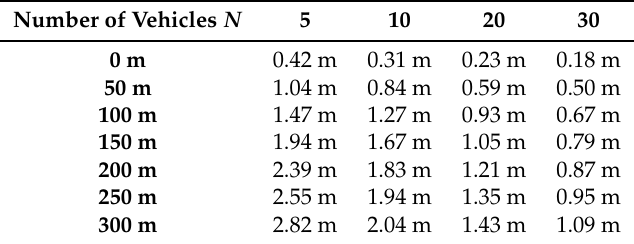
Table 2. Absolute error trends depending on the number of vehicles and the radius of an anchor.